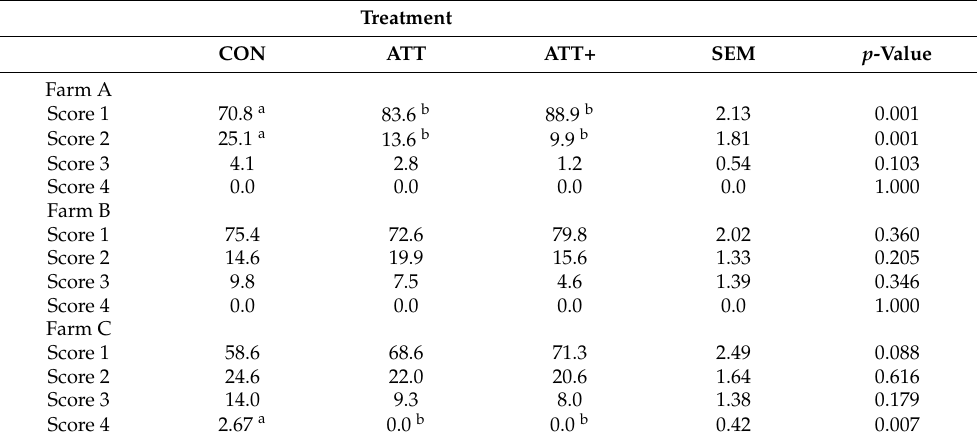
Table 6. Treatment effects on the % of cases of fecal consistency score in the different scoring categories on the study of the farms as assessed at the first week post-weaning. Treatment CON ATT ATT+